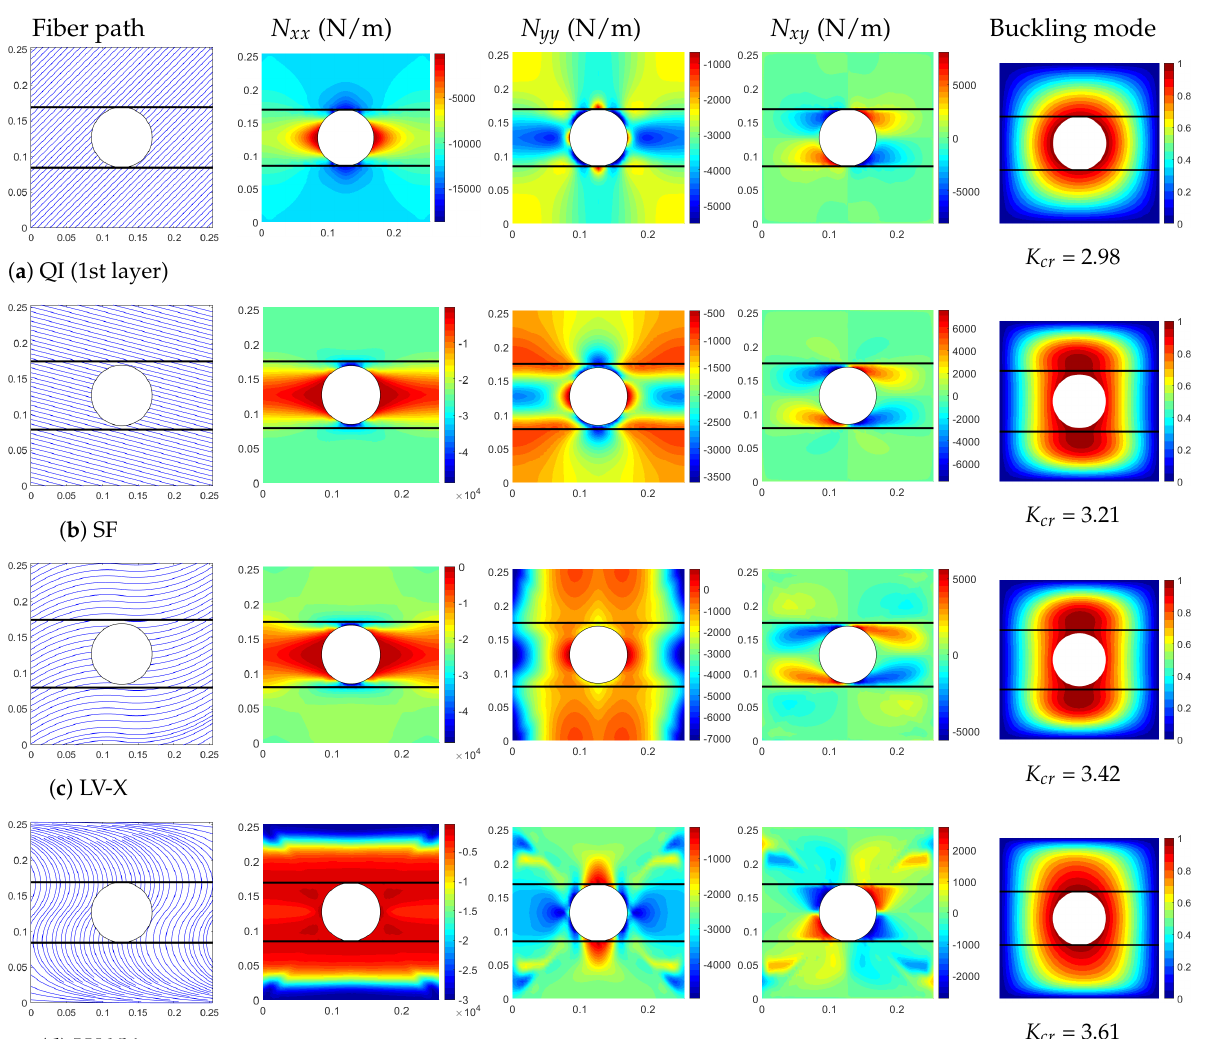
Figure 11. Comparison of optimal fiber paths, stress resultants and buckling modes for different study cases of the stiffened VAT laminates with a central hole under uniform axial displacements; the line drop in the fiber path plot does not mean the fiber cut in this study. ( a ) QI laminate design; ( b ) SF laminate design; ( c ) LV-X laminate design; ( d ) LV-XY laminate